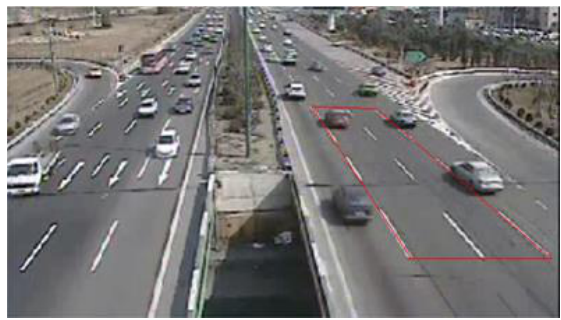
Figure 7: Definition of ground coordinate system.